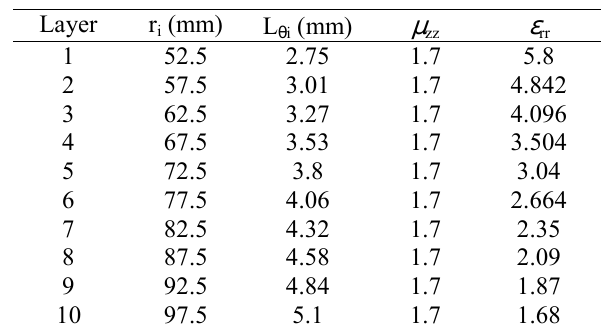
Table 1: Electromagnetic parameters m zz , and e rr for the 10 cells of the metamaterial layers. The length L q of each cell is given as a function of its position along the layer.